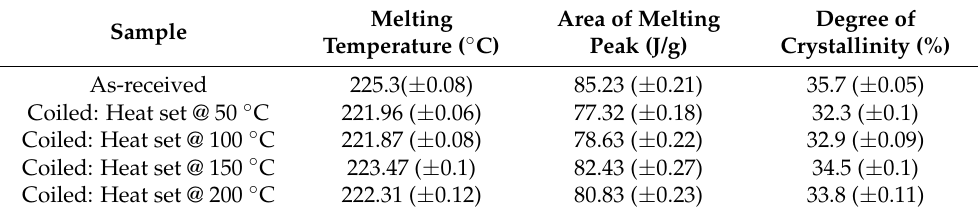
Figure 3. Properties of coiled fibre (actuator): ( A ) SEM images showing the coil structure, ( B ) DSC thermograms of fibres with different heat set temperature, ( C ) TGA thermograms showing the amount of moisture is non-dried and dried fibres. Table 1. DSC analysis results of nylon 6 fibres.